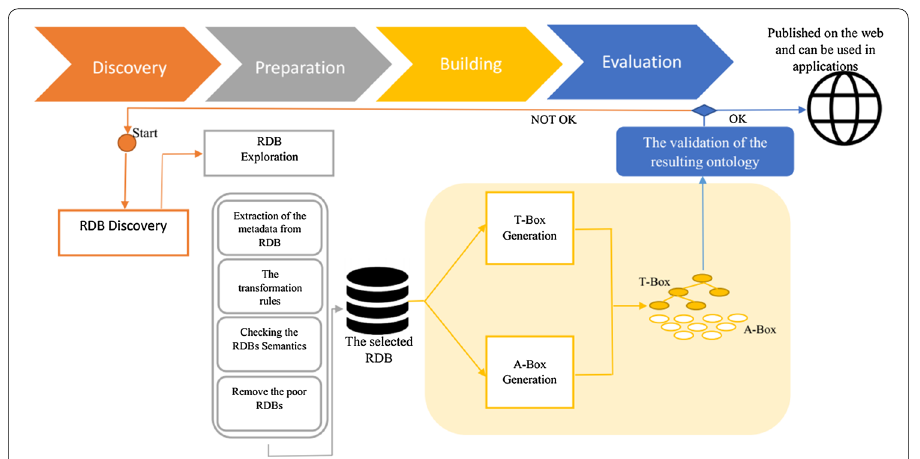
Fig. 2 The method of building the ontology from